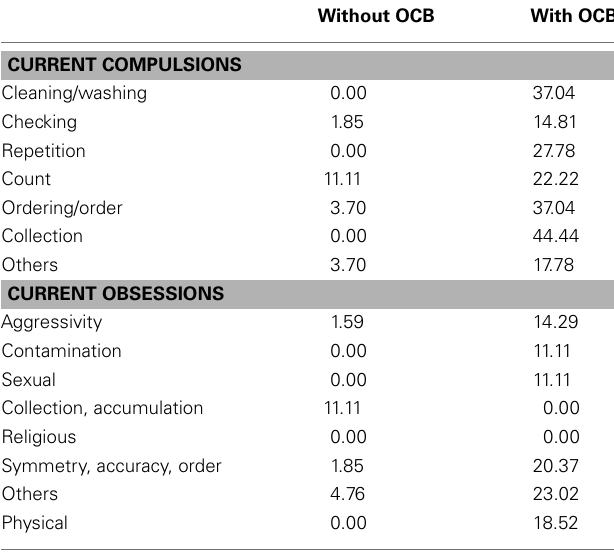
Table 6 | Frequency tables forTS’s current compulsions and